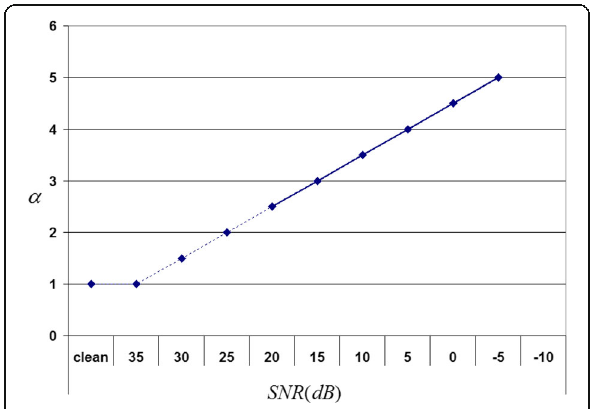
Fig. 6 Change in the parameter α with SNR on Aurora 2 task